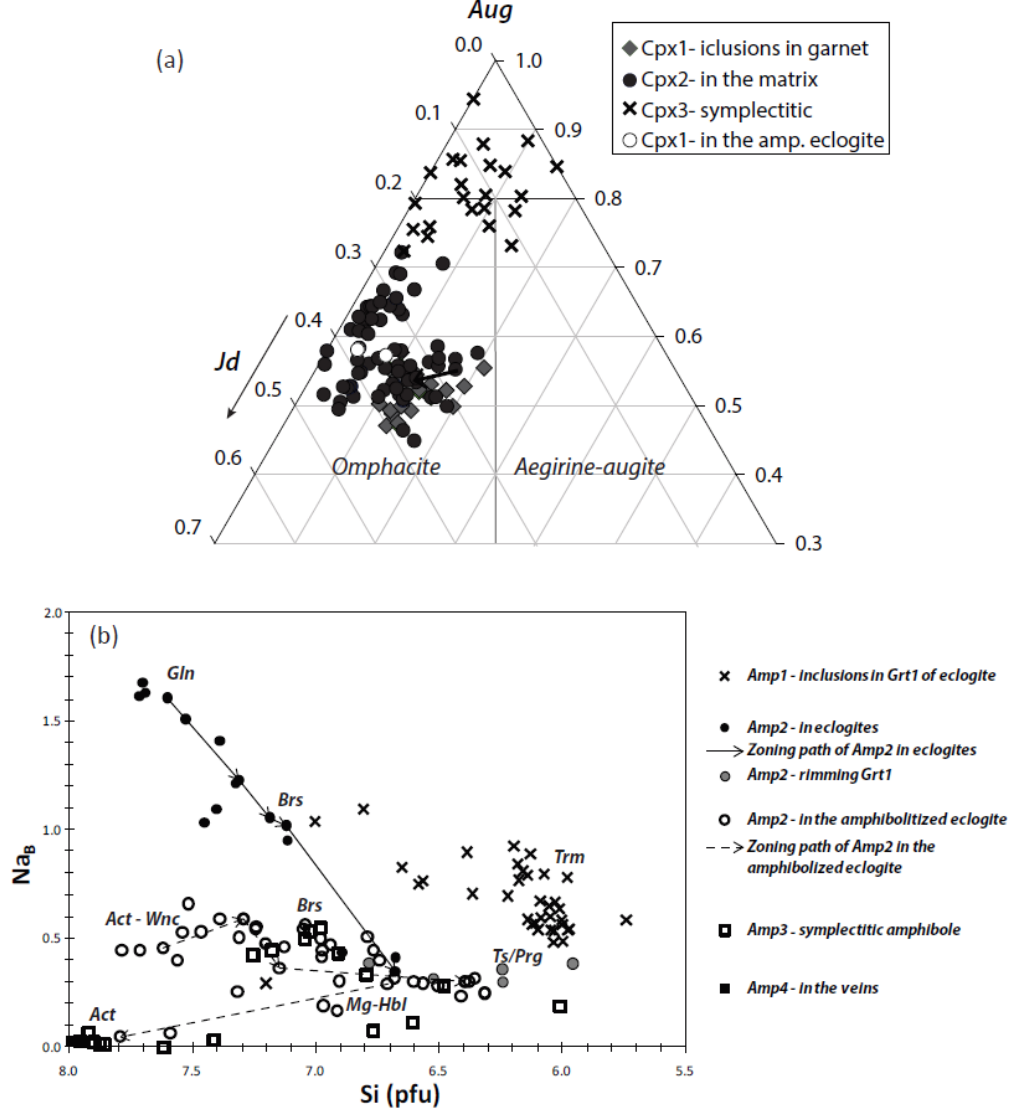
Figure 7. ( a ) Chemical composition of clinopyroxene from eclogites and amphibolitized eclogite; ( b ) Chemical composition of amphiboles from eclogites and amphibolitized eclogite.